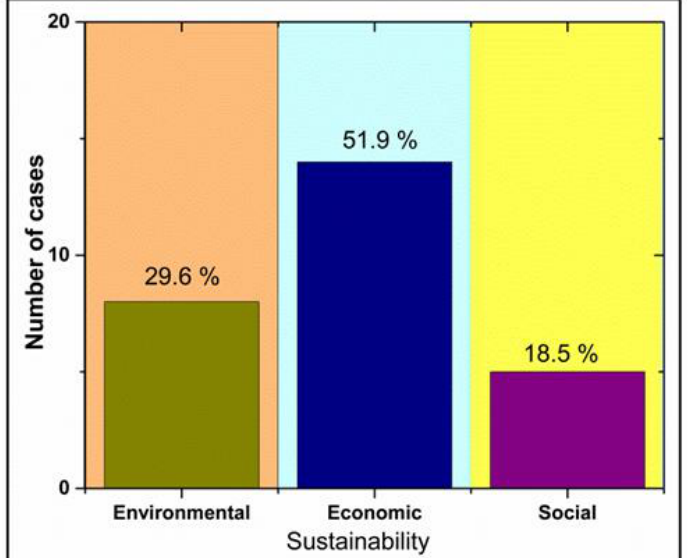
Figure 4. Distribution of the case studies under the I4.0 approach.